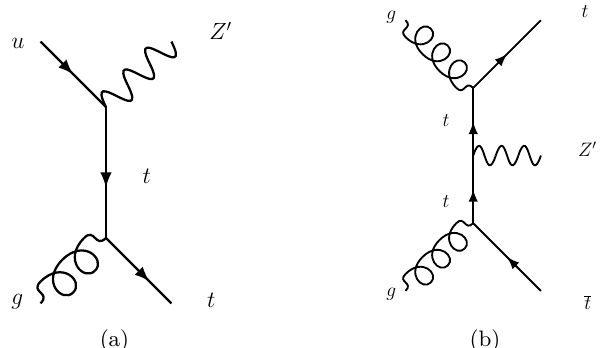
Figure 1 . Representative diagrams for some of the most relevant processes: (a) tZ 0 production and (b) ttZ 0 production.